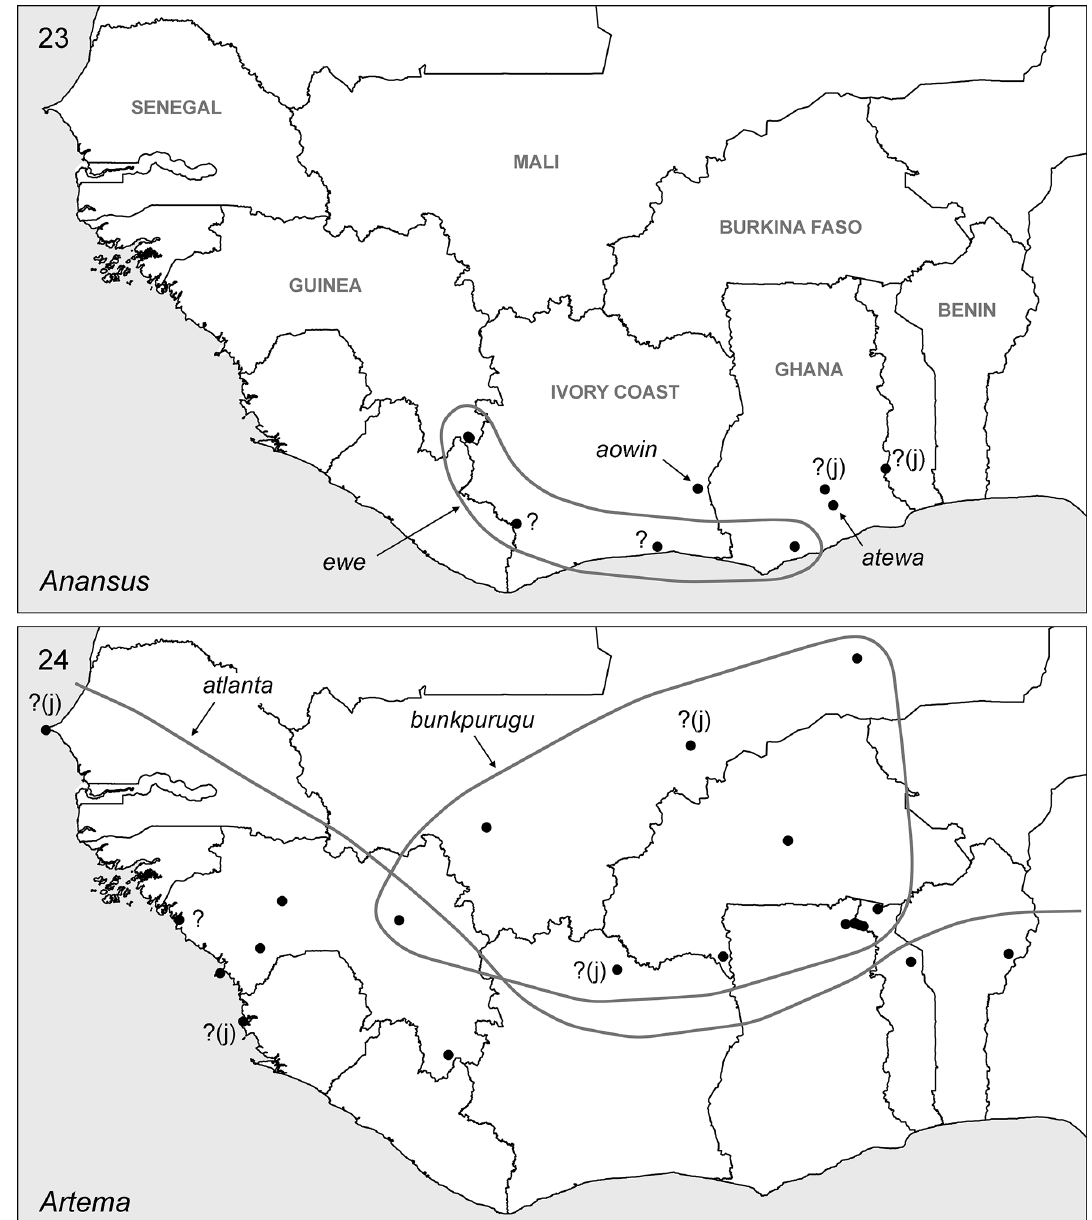
Figs 23-24. Known distributions of the genera Anansus Huber, 2007 and Artema Walckenaer, 1837 in West Africa. Question marks denote uncertain identifications ( Anansus ewe : two localities with females only) or impossible identifications [“?(j)”: juveniles